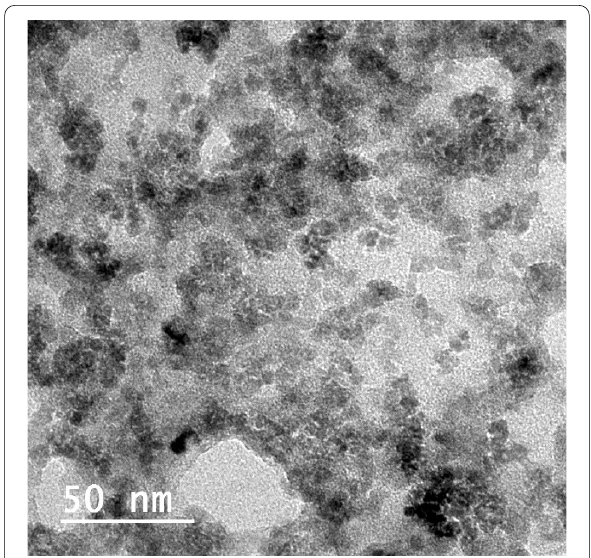
Fig. 3 MNPs’ dispersion within dextran matrix explained by TEM with magnification scale 50 nm